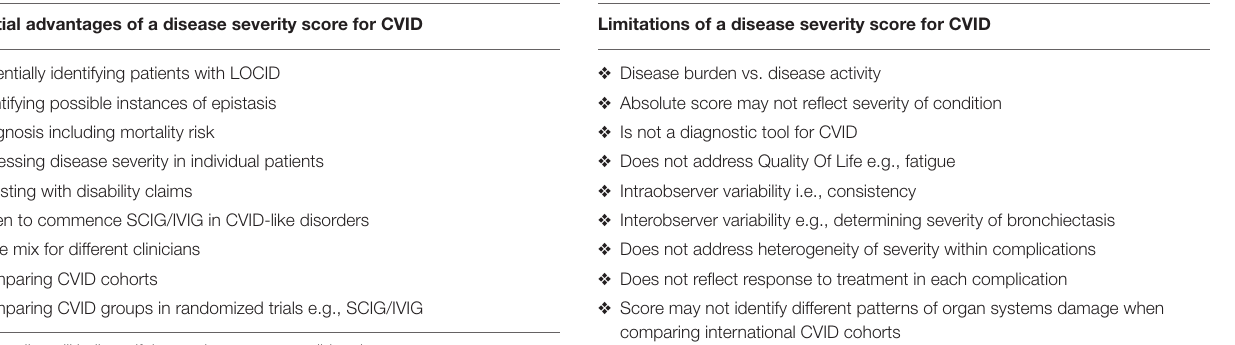
TABLE 3 | Disadvantages of a disease severity score for